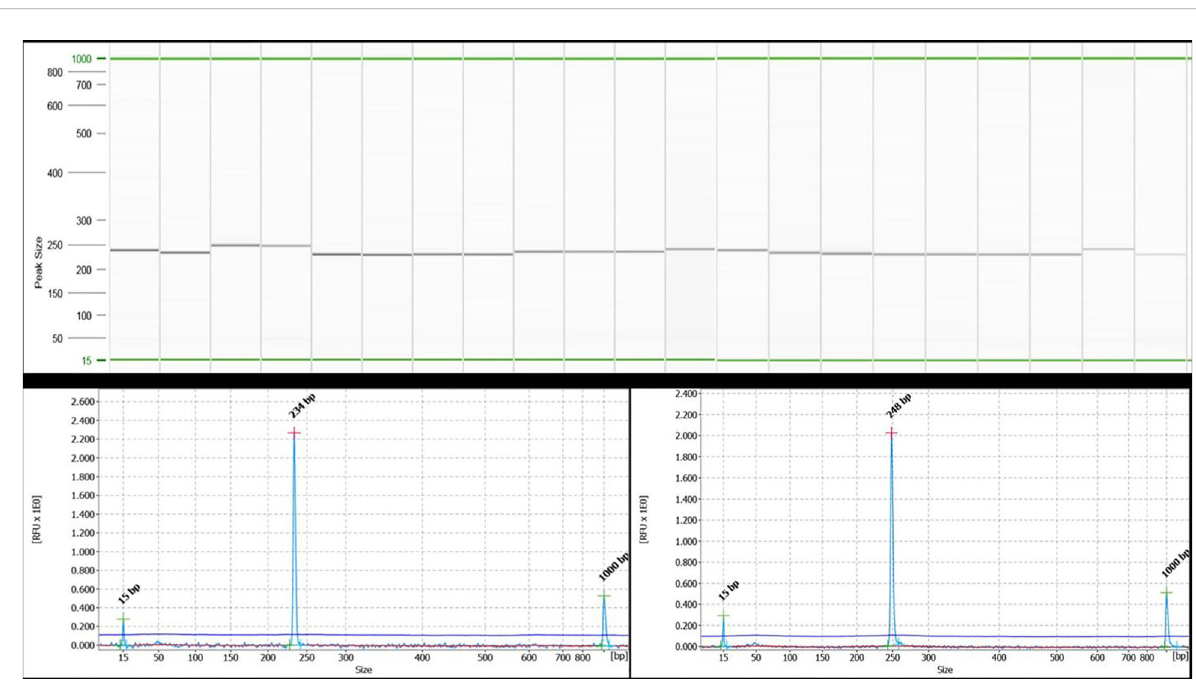
FIGURE 6 QIAxcel gel image of PCR ampli fi cation using the black pepper chloroplast SSR marker BPC5 in 21 accessions of 12 different species of black pepper as captured on the QIAxcel ScreenGel software. Lanes 1 and 2: Piper longum ; lanes 3 and 4: Piper arboreum ; lanes 5 and 6: Piper argyrophylum ; lane 7: Piper attenuatum ; lanes 8 – 10: Piper betel ; lanes 11 and 12: Piper chaba ; lane 13: Piper hymenophyllum ; lanes 14 and 15: Piper trichostachyon ; lane 16: Piper wallichi ; lanes 17 – 19: Piper nigrum ; lane 20: Piper columbrinum ; lane 21: Piper sarmentosum . The